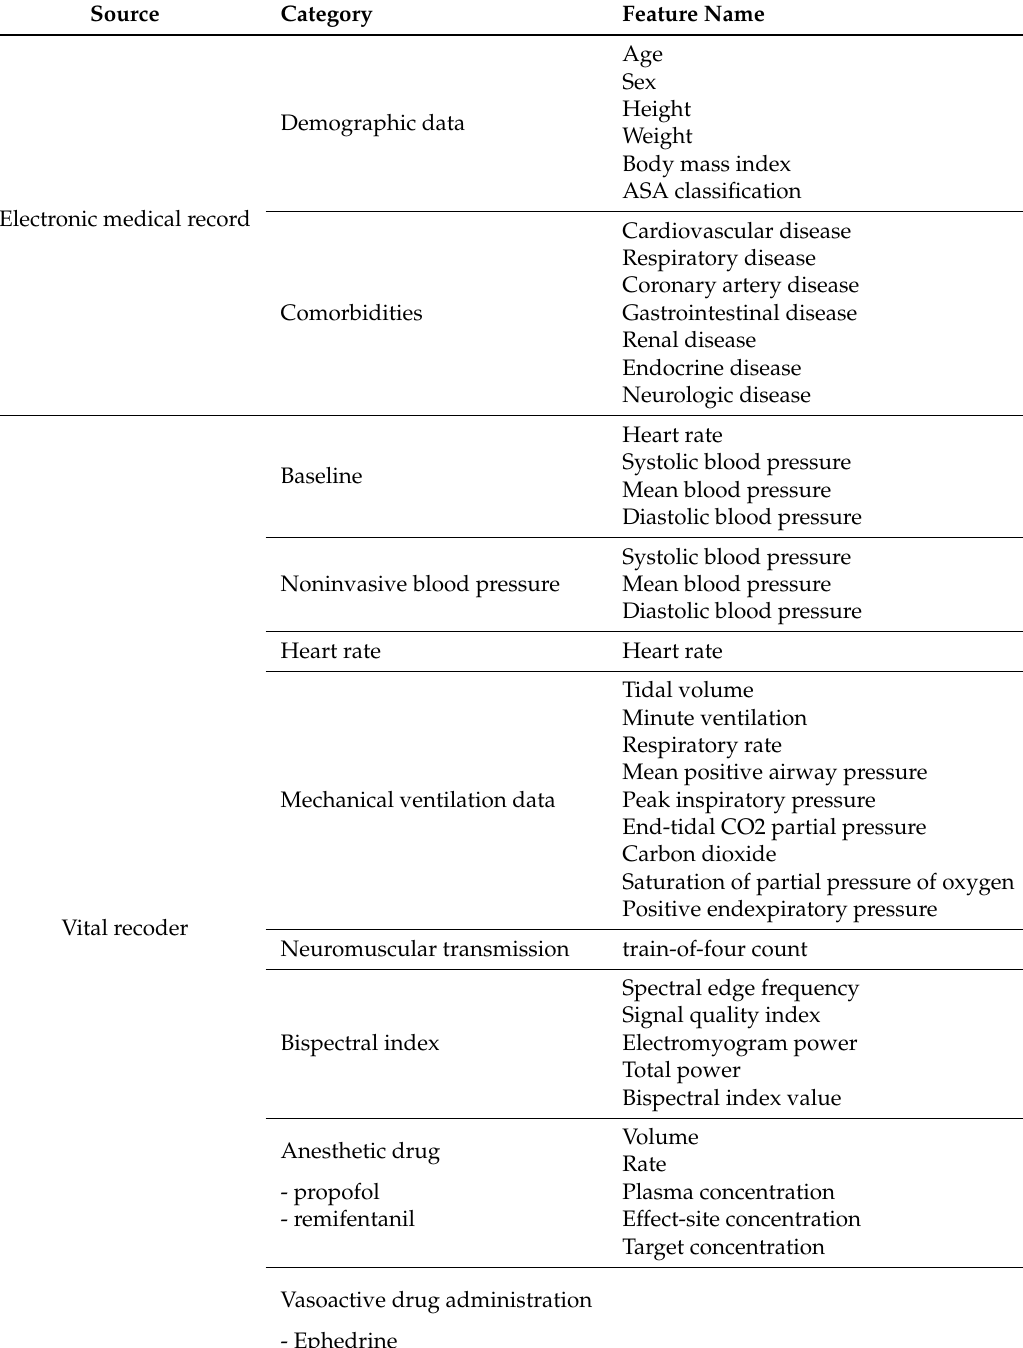
Table 1. Description of collected